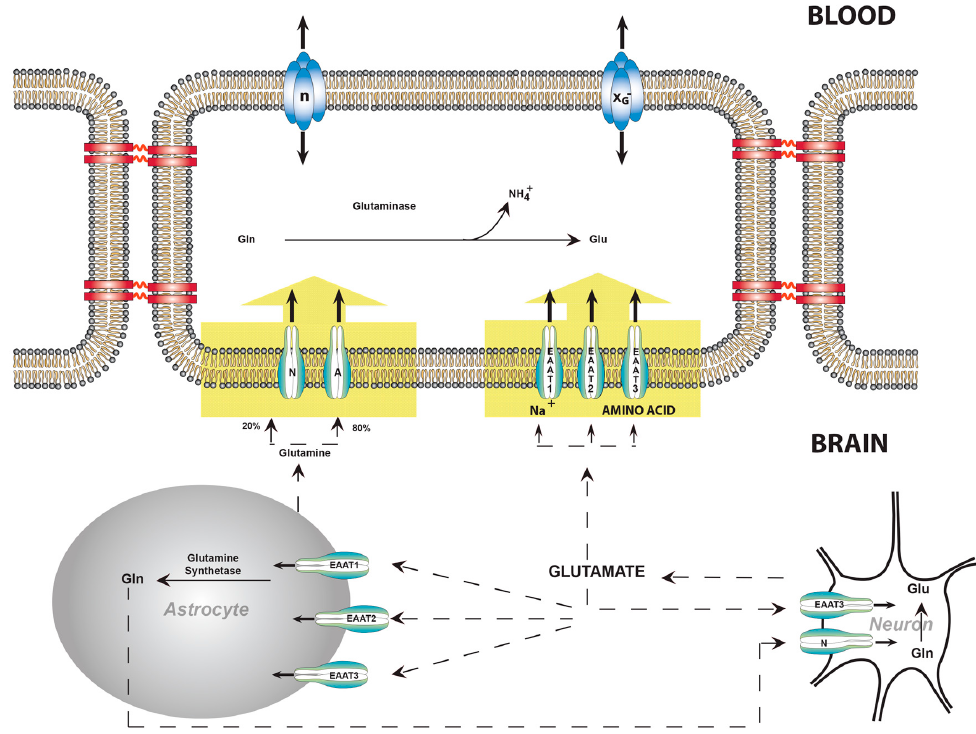
Figure 2. Glutamate and glutamine transport between neurons, astrocytes, and endothelial cells of the blood–brain barrier. Glutamate is the most abundant excitatory neurotransmitter in the mammalian nervous system. At chemical synapses, glutamate is stored in vesicles. Nerve impulses trigger the release of glutamate from the pre-synaptic cell. Na + -dependent glutamate transporters (EAATs)